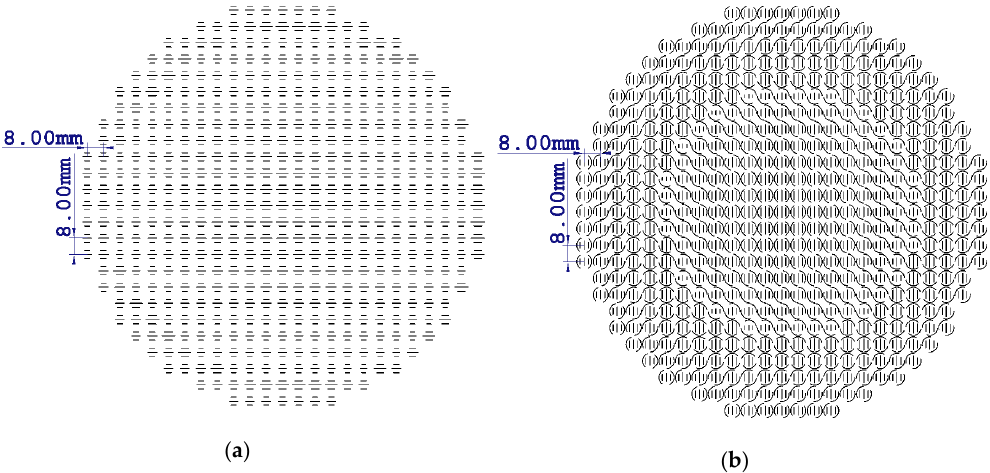
Figure 7. ( a ) Reflectarray layout printed on the bottom side of the upper dielectric layer. ( b ) Reflectarray layout printed on the upper side of the upper dielectric layer.